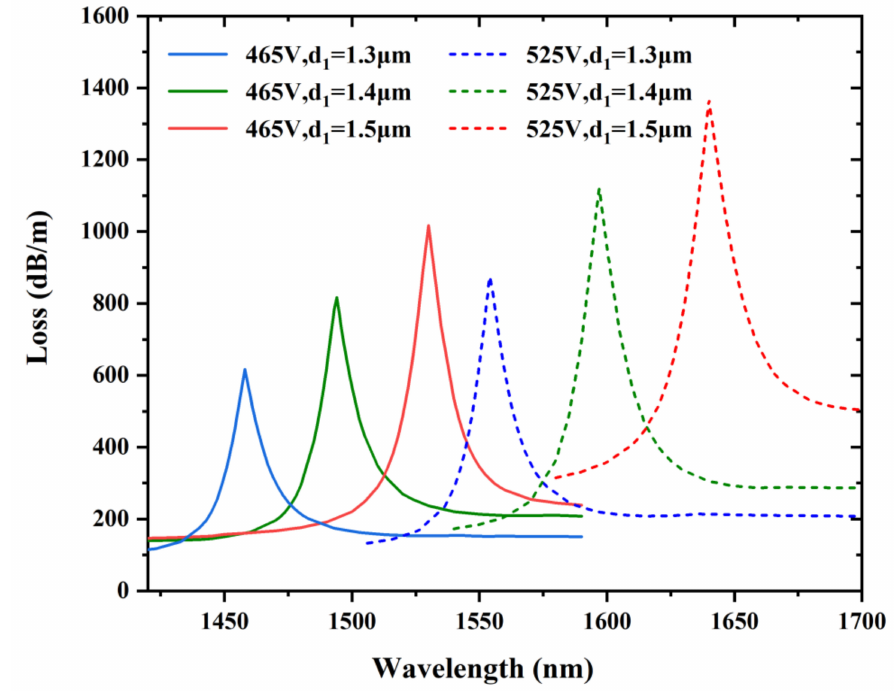
Figure 7. Variation in the confinement loss at the voltages of 465 and 525 V by varying the LC filled hole diameter d 1 = 1.3, 1.4, and 1.5 µ m, while other structural parameters are d = 1.4 µ m, d 2 = 2.2 µ m, and Λ = 3 µ m.